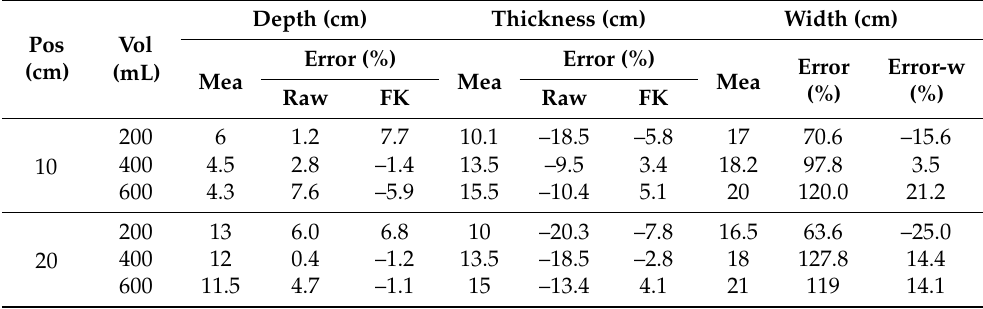
Table 8. GPR detection error of the moistube irrigation SWB at the shorter scan